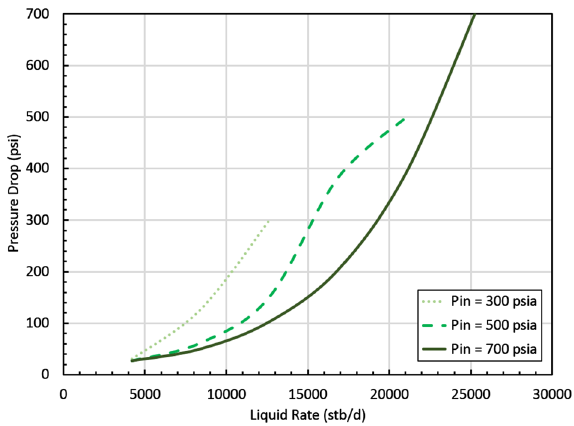
Fig. 6 Influence of the inlet pressure on the performance curve of pipeline A. The WC and GOR are held constant and equal to 45% and 1800 scf/stb respectively